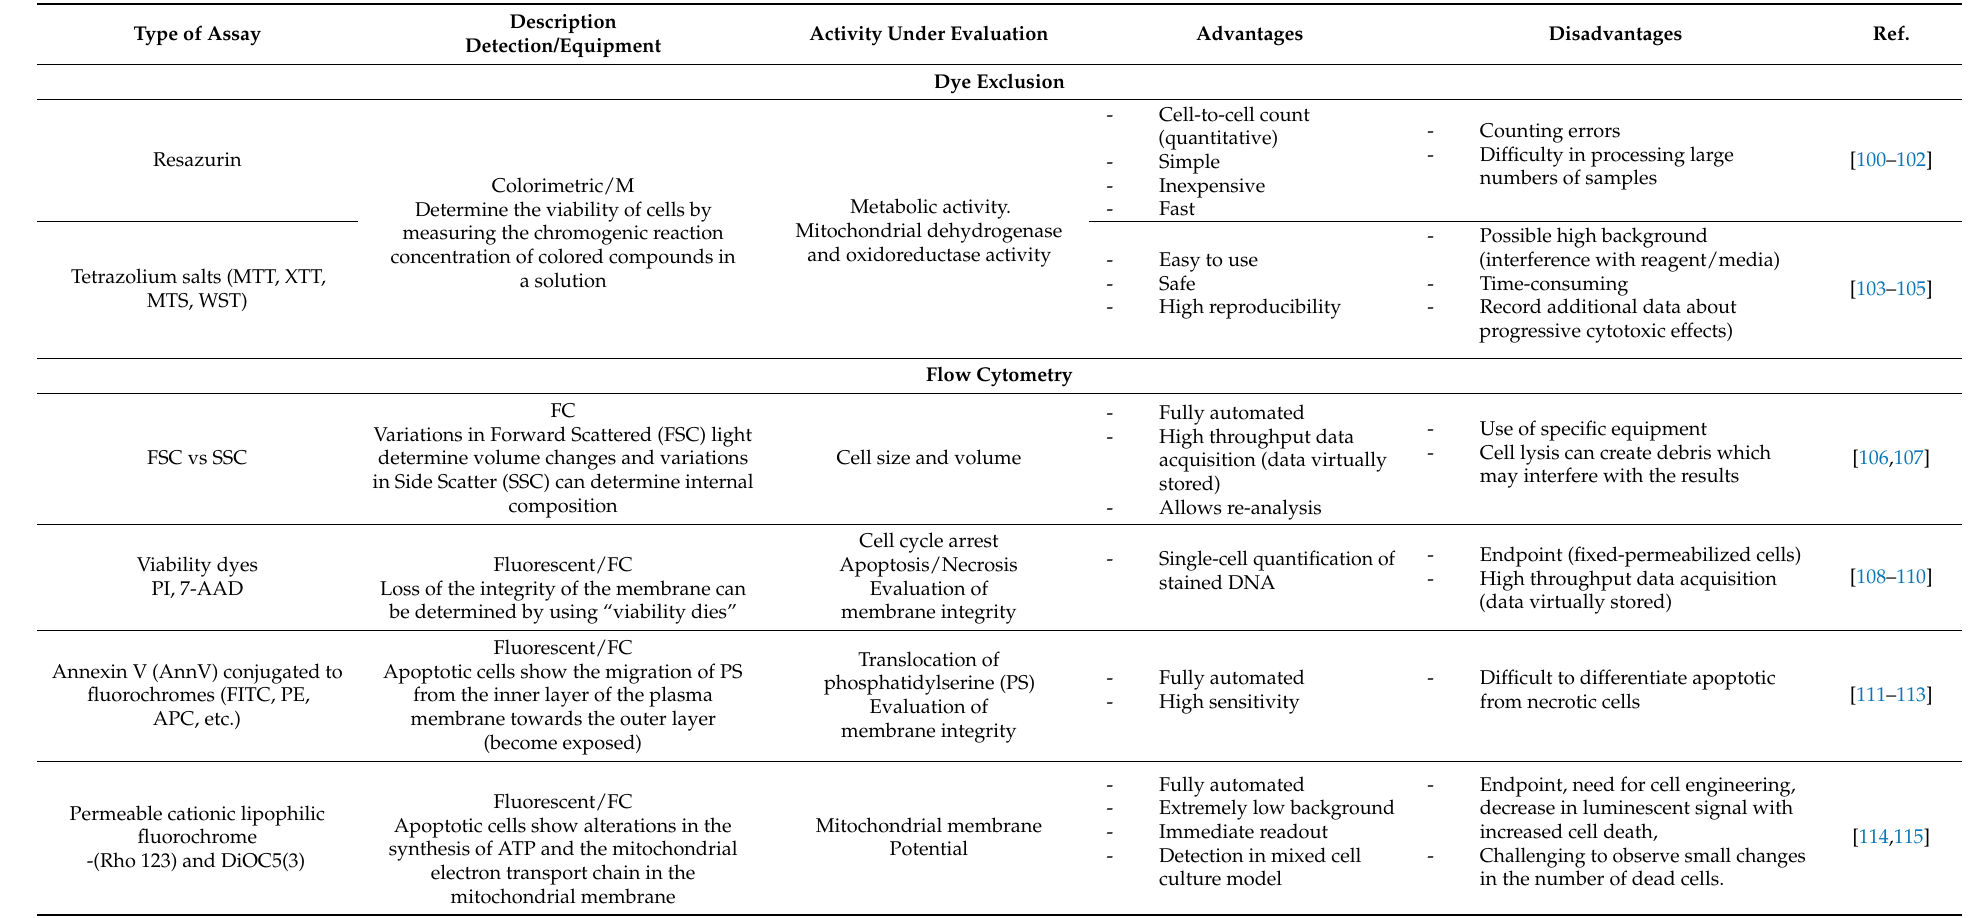
Table 2. Methods of evaluation for antiparasitic activity in unicellular parasites